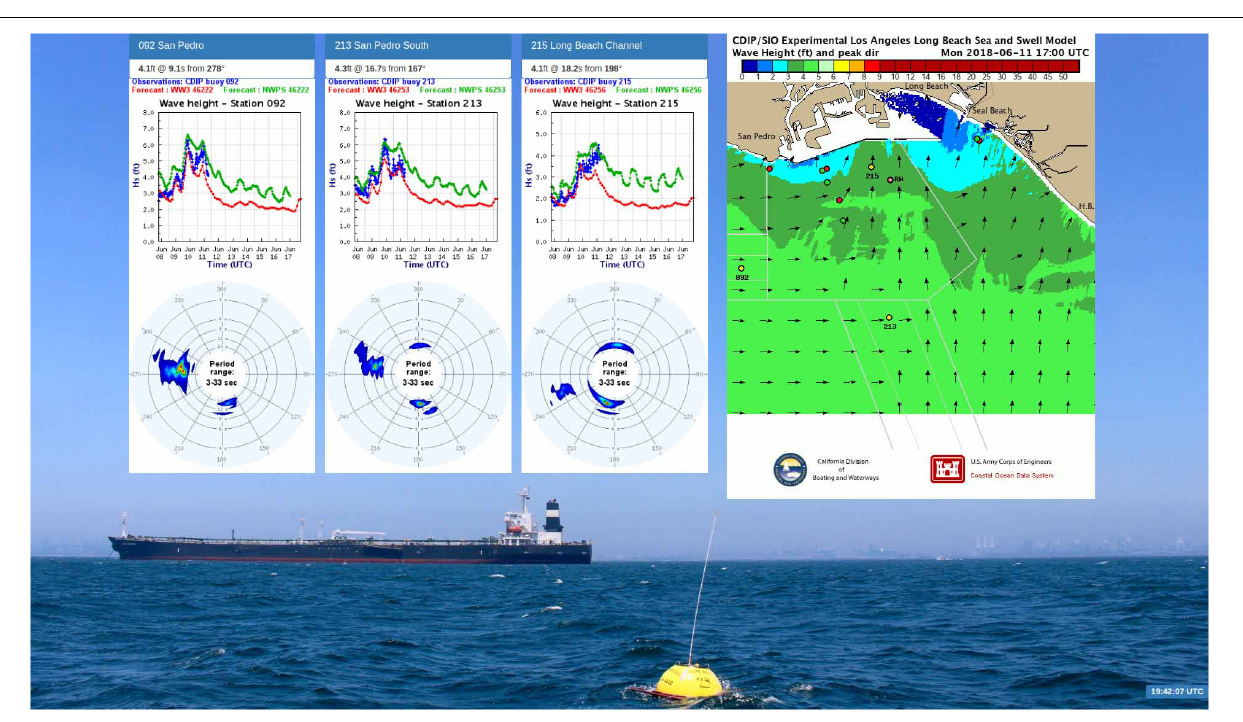
FIGURE 9 | A web display at the Marine Exchange of Southern California, San Pedro updates every 30 min (http://cdip.ucsd.edu/custom_pages/marine_exchange/). The three graphs highlight the differences between the buoy observations (blue), WW III (red) and the NWPS